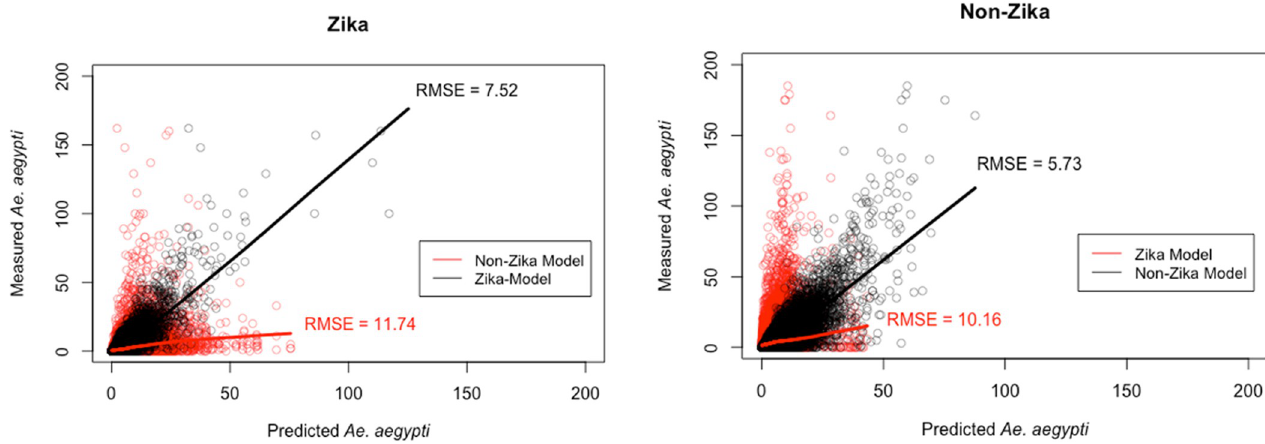
Fig 6. Predicted versus measured values for Ae . aegypti trap counts. These plots are shown for regions affected by local transmission of Zika during the 2016 outbreak (left) and unaffected regions (right), as predicted with random forest model trained on data from the respective region’s traps (black) or the opposite region’s traps